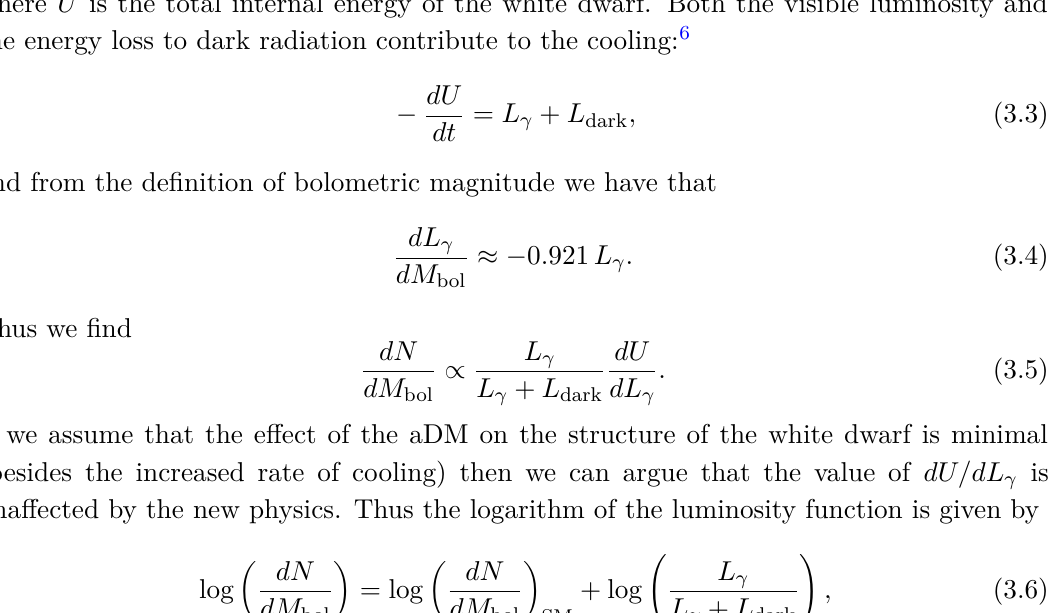
Figure 1 . Red data points: the measured white dwarf luminosity function for white dwarfs showing only hydrogen features in their atmospheres, assuming a constant formation rate [140]. Blue curve: theoretical prediction resulting from detailed modeling of the WDLF [50]. Blue dotted line: the simple approximate prediction of Mestel’s law. Black curves : predicted luminosity functions with accumulated aDM for different values of (cid:15) , with dark atom masses { m 10% of the local dark matter density. The deviations from Standard Model predictions are more pronounced for older, cooler white dwarf stars, and become more significant for higher values of (cid:15) . As is conventional, the SM WLDF predictions are normalized to pass through the point with the smallest error bars. The aDM curves are normalized to the SM one at small magnitudes, to emphasise that deviations from predicted behaviour are most dramatic at larger